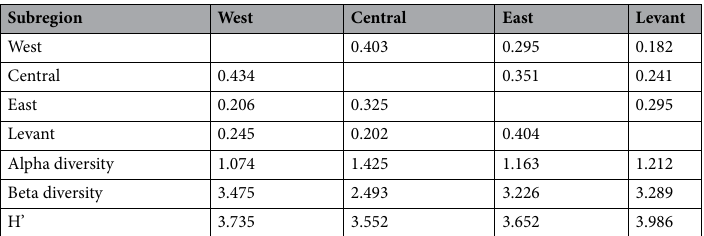
Subregion West Central East Levant West